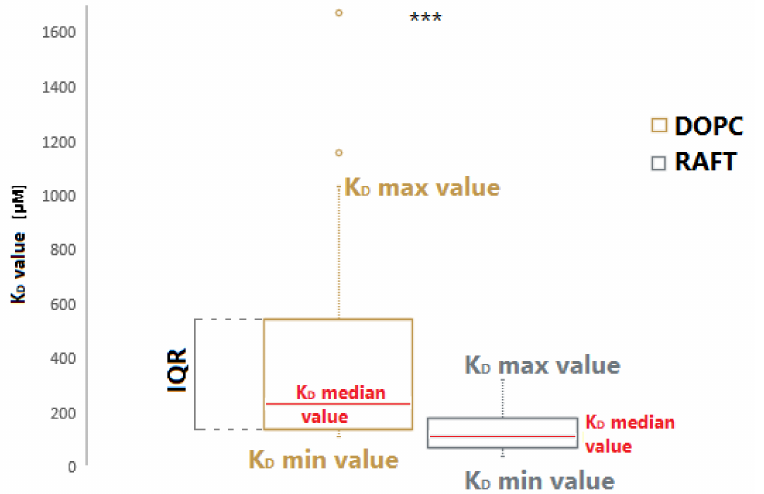
Figure 2. The range of K D values for binding RNA aptamers to DOPC and raft membranes. The box shows the interquartile range (IQR) of the K D measurements. The comparison of the median K D values (marked in red) for binding RNA aptamers to DOPC membranes is 232 µ M (left) and to raft membranes is 113 µ M (right), indicates stronger RNA aptamer interaction with raft membranes rather than disordered membranes. The whiskers (dotted line) restrict the K D value range and mark the minimal and maximal K D values. The circles in the top of the boxplot are the outliers (n DOPC = 20, n RAFT = 30). The symbol *** means that p < 0.001 (Mann–Whitney U test of differences in medians).